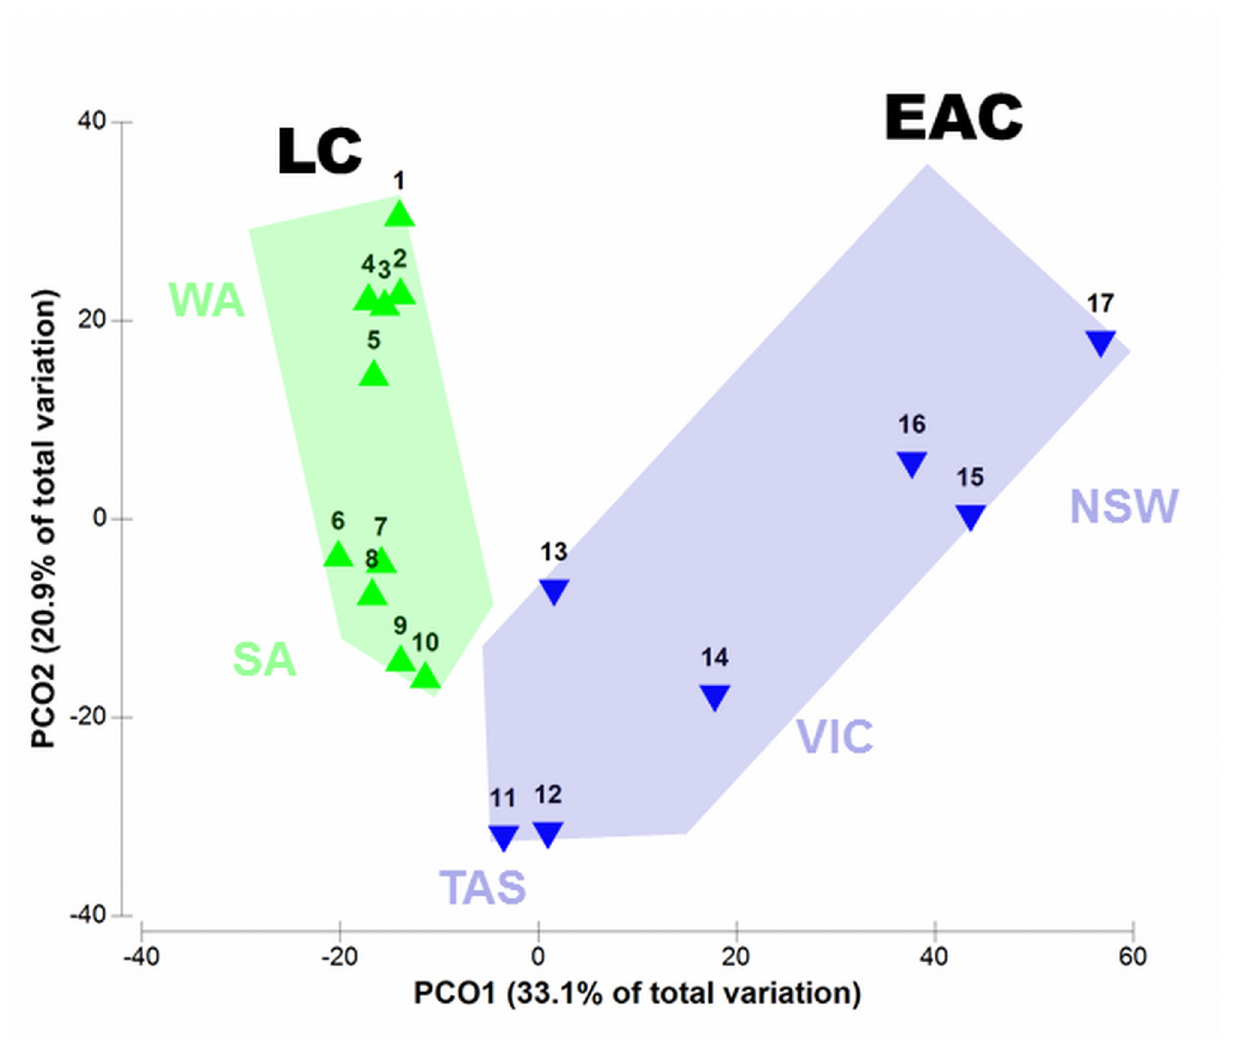
Figure 2. Principal Component Ordination (PCO) of seaweed community structure from bioregions swept by the Leeuwin Current (LC = green triangles) and the East Australia Current (EAC = blue triangles). See Figure 1 for spatial arrangement of regions. The green and blue arrows indicate the current systems super-imposed onto the ordination to illustrate the magnitude of floristic change across the current system (length of arrow) and the variation in community structure among regions within the system (width of arrow). There was significant sequential change in community structure along both current